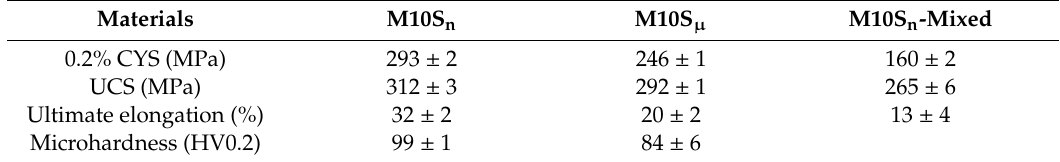
Figure 2. Compressive stress–strain curves of M10S n M10S µ , M10S n -mixed composites with inserted macrographs the samples before and after compression test. Table 2. Room temperature compressive mechanical properties of extruded Mg–SiC composites.